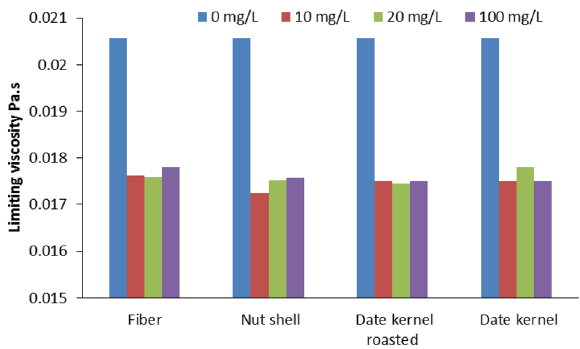
Fig. 12 Limiting viscosity of heavy crude oil with 150 µm bio mate-